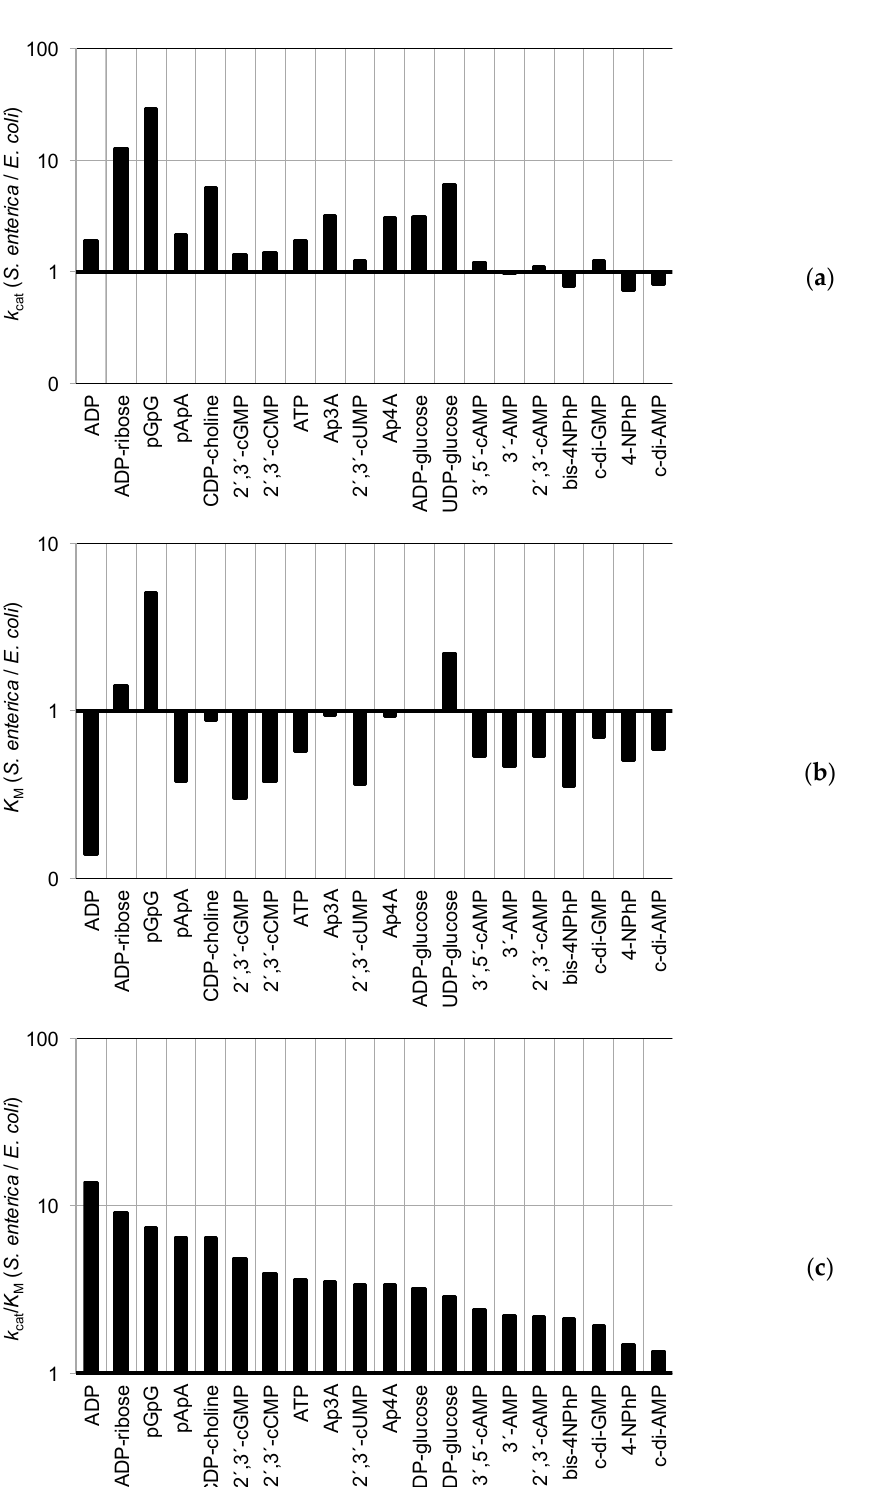
Figure 2. Comparison of kinetic parameters of S. enterica CpdB versus E. coli CpdB for different substrates. S. enterica data are taken from Table 1, while those for E. coli were from previous work [7]. The bars represent parameter ratios in logarithmic scale: ( a ) ratios of k cat values; ( b ) ratios of K M values; ( c ) ratios of k cat /K M values. In the three panels, the substrates are ordered from higher to lower ratios of catalytic efficiency.